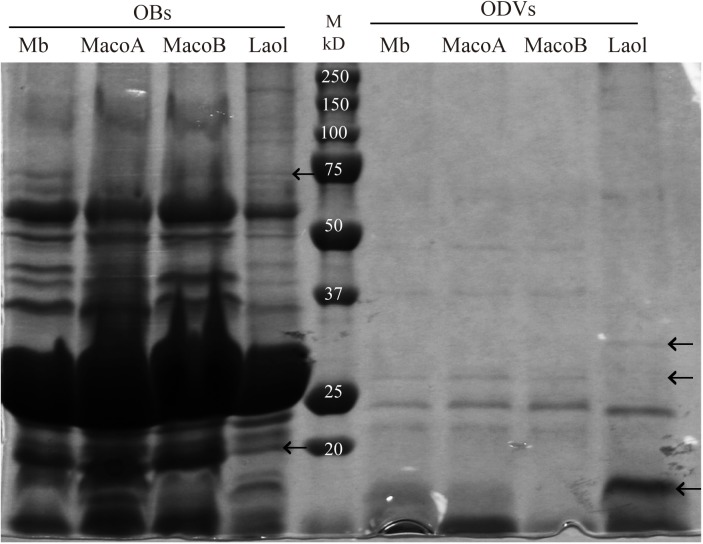
OB and ODV structural polypeptides patterns.OB and ODV structural polypeptides profiles of MbMNPV (Mb), MacoNPV-A (MacoA), MacoNPV-B (MacoB) and the virus under study (LaolNPV). OBs and harvested ODVs after solubilization were electrophoresed on an 11% SDS-PAGE gel. The molecular weights of the fragmets of the Precision Plus Protein All Blue marker, from Bio-Rad, (M) are indicated above each band. The arrows indicated the differences observed in the presence and absence of proteins fragments and in differences in molecular weights.